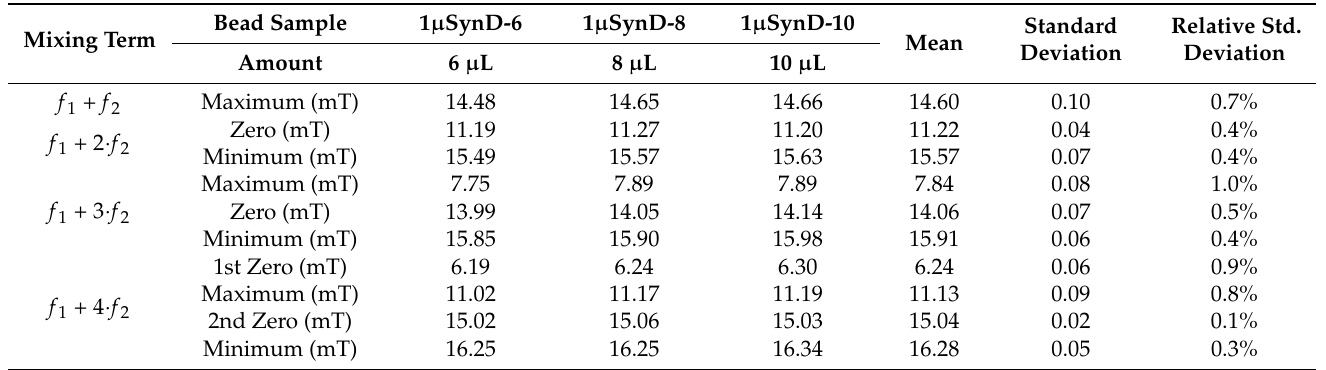
Table 1. The determining feature locations for samples with different amounts of magnetic bead solution. Mixing Term